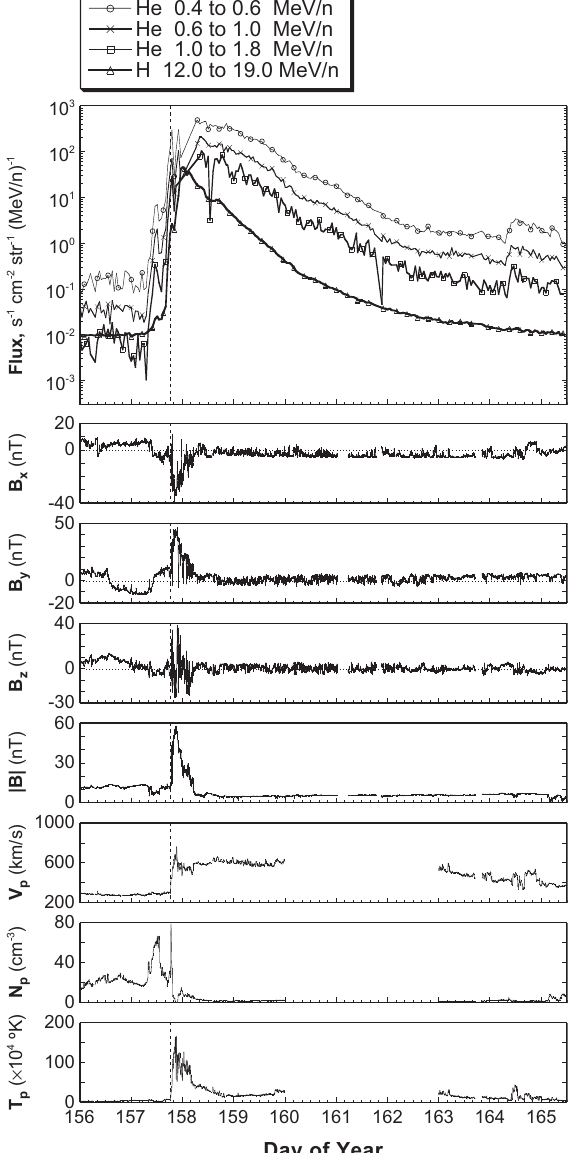
Fig. 13. Energetic particle fluxes, magnetic fields and solar wind plasma data for the 23–26 September 1978 event. This particle event occurs well away from any strong interplanetary